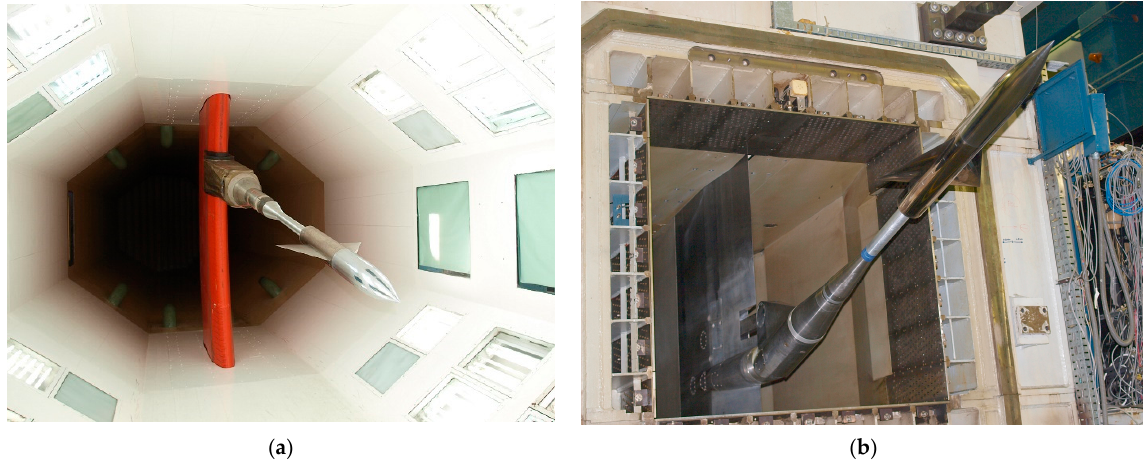
Figure 7. The 115.8 mm diameter AGARD-B standard model: ( a ) the model in the test section of the T-35 wind tunnel [44]; ( b ) the model in the test section of the T-38 wind tunnel.